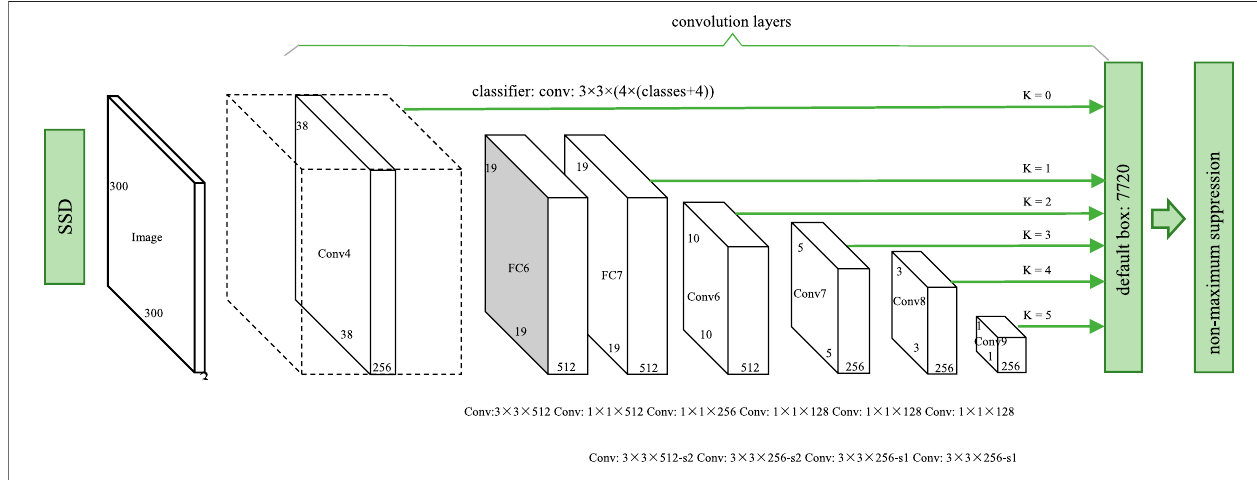
FIGURE 3 | SSD object detection framework.